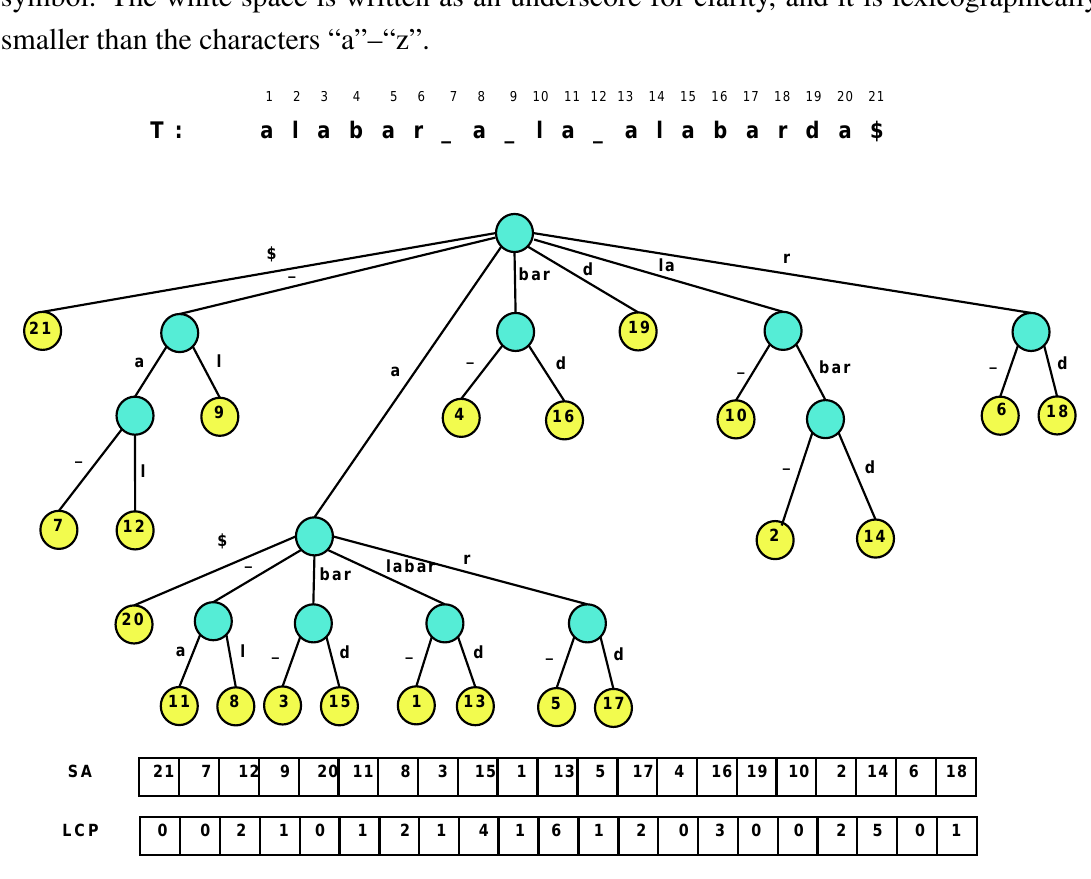
Figure 1. The suffix tree of the text “alabar a la alabarda$”, where the “$” is a terminator symbol. The white space is written as an underscore for clarity, and it is lexicographically smaller than the characters